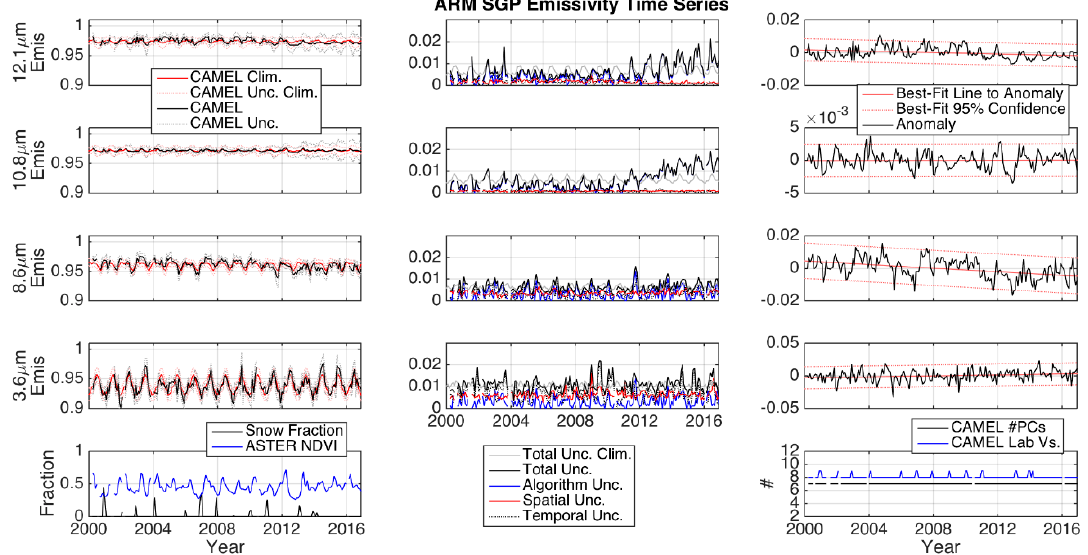
Figure 4. Time series over the ARM SGP site of the (left) CAMEL monthly and climatological emissivity, (middle) the CAMEL monthly and climatological uncertainty, and (right) the CAMEL monthly emissivity anomalies with a best fit line. Bottom row shows the (bottom, left) monthly snow fraction and NDVI and (bottom, right) lab version and number of PCs for the monthly CAMEL HSR emissivity.